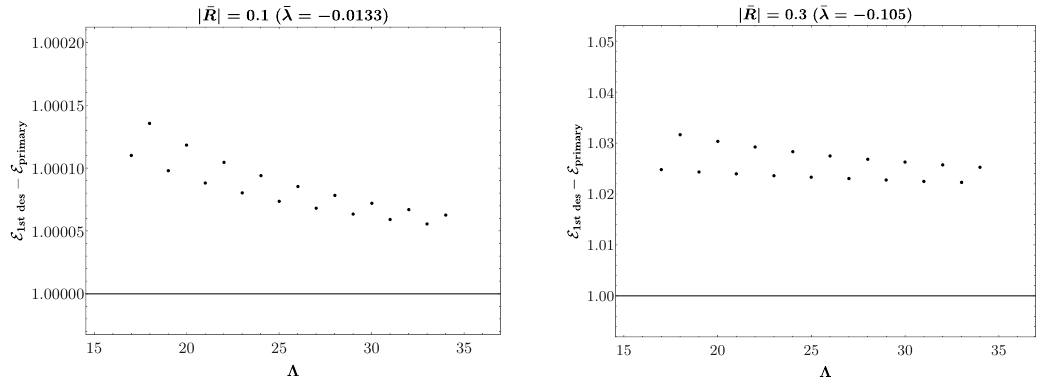
Figure 30. Energy gap between the first primary and its first descendant, as a function of the cutoff, for two choices of negative magnetic field, ¯ λ < 0